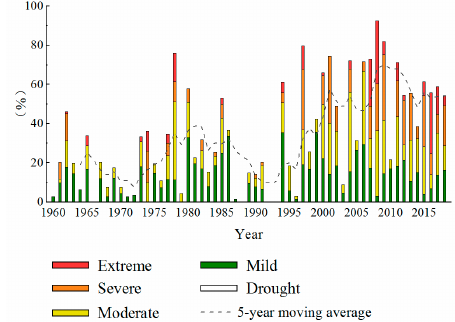
Figure 6. The changes of arid area ratio over the years, in plant growing season.